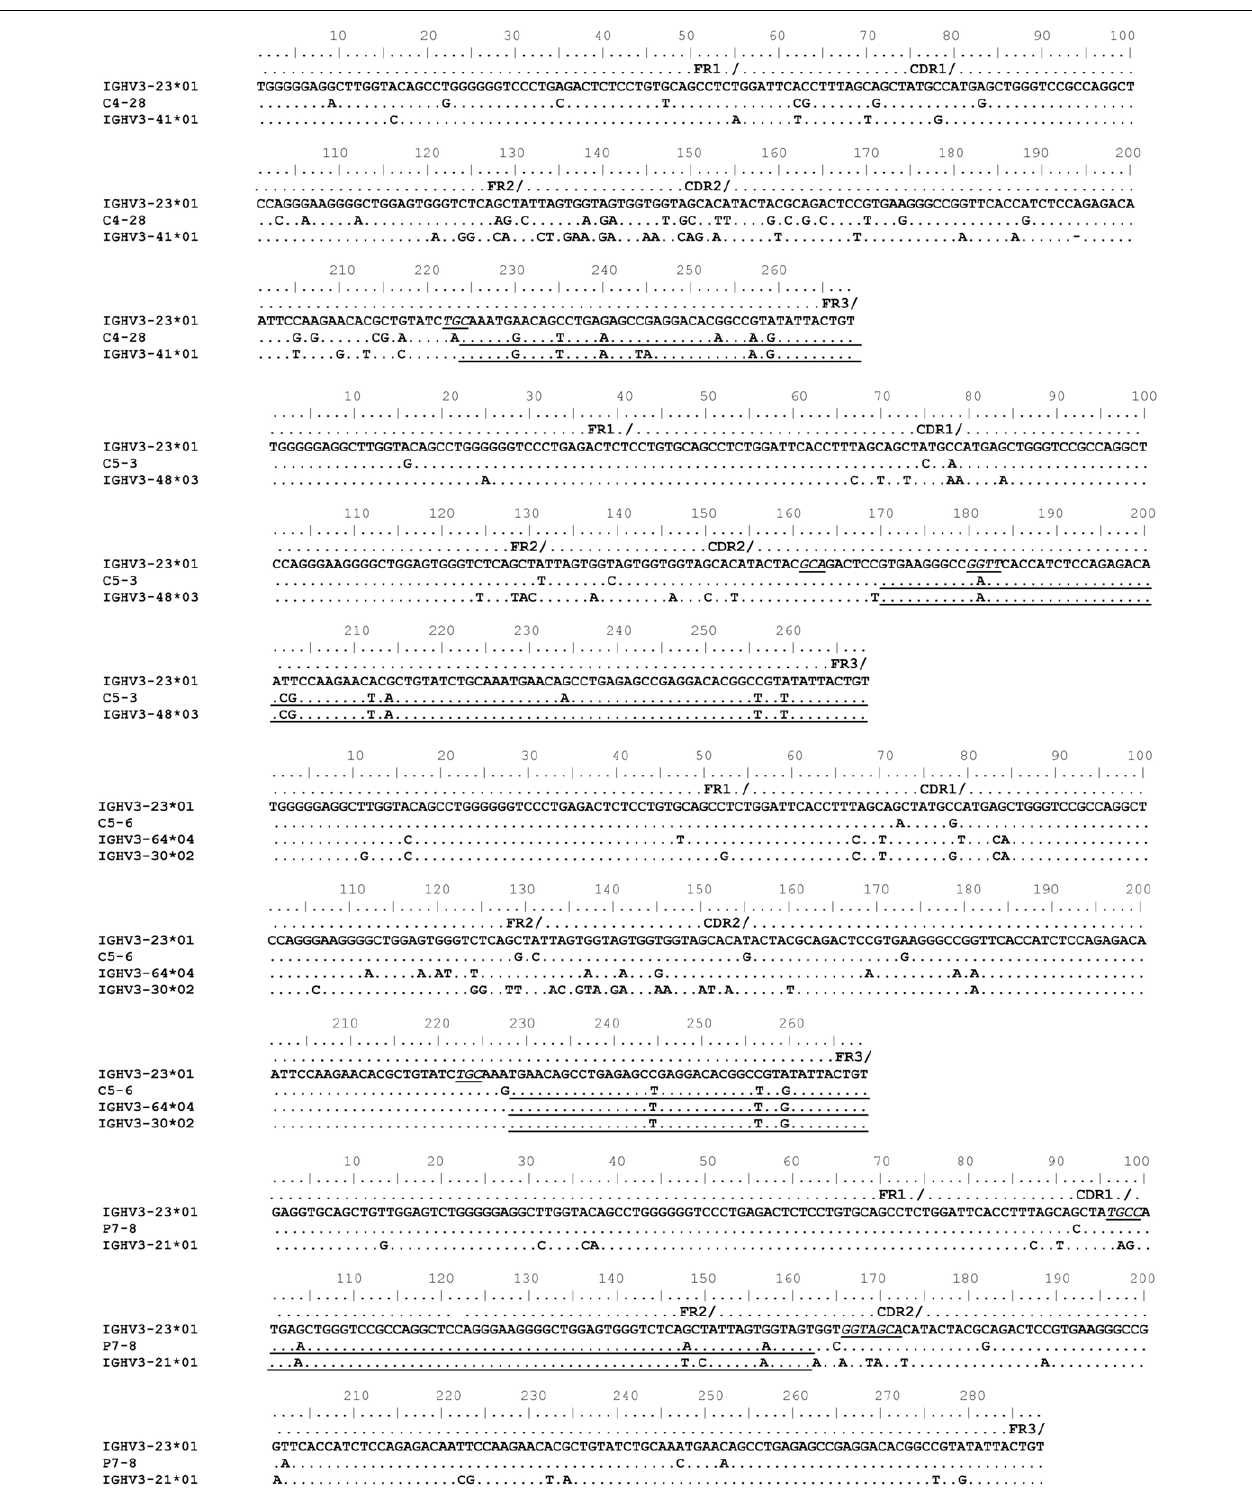
C5–3, C5–6) and a CVID patient (P7–8). Potential donor germline IGHV3 family gene segments are shown below the rearranged IGHV3-23*01 sequences. GCV-like tracts are underlined. Flanking SHM/AID hotspot motifs are underlined and